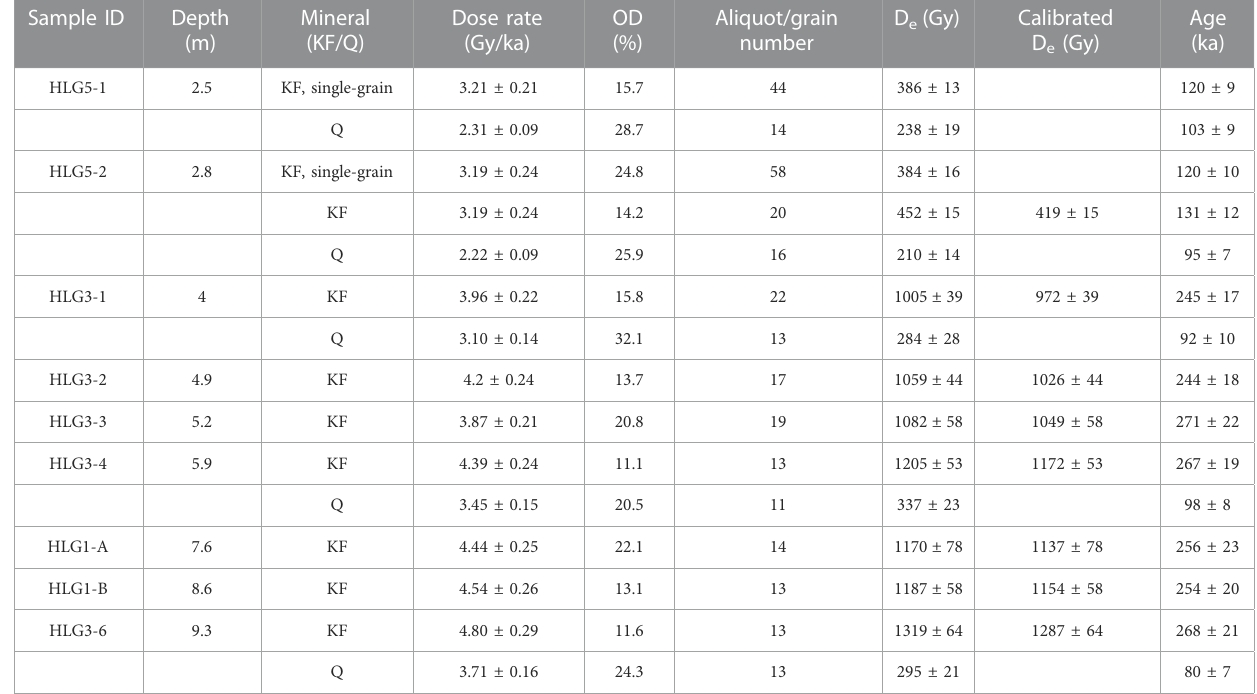
TABLE 2 Dating results of quartz OSL and KF MET-pIRIR. Sample